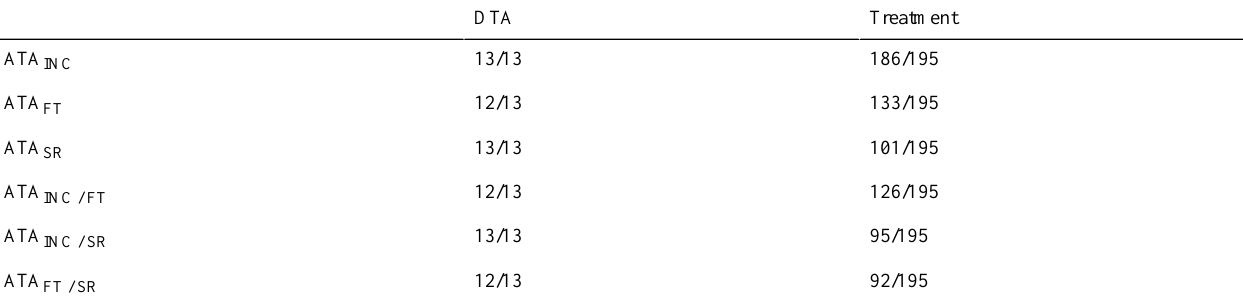
Table 3. Table 3. Summary of the sample sizes (number of reviews reporting nonzero values) for evaluating each of the expected manifestations.